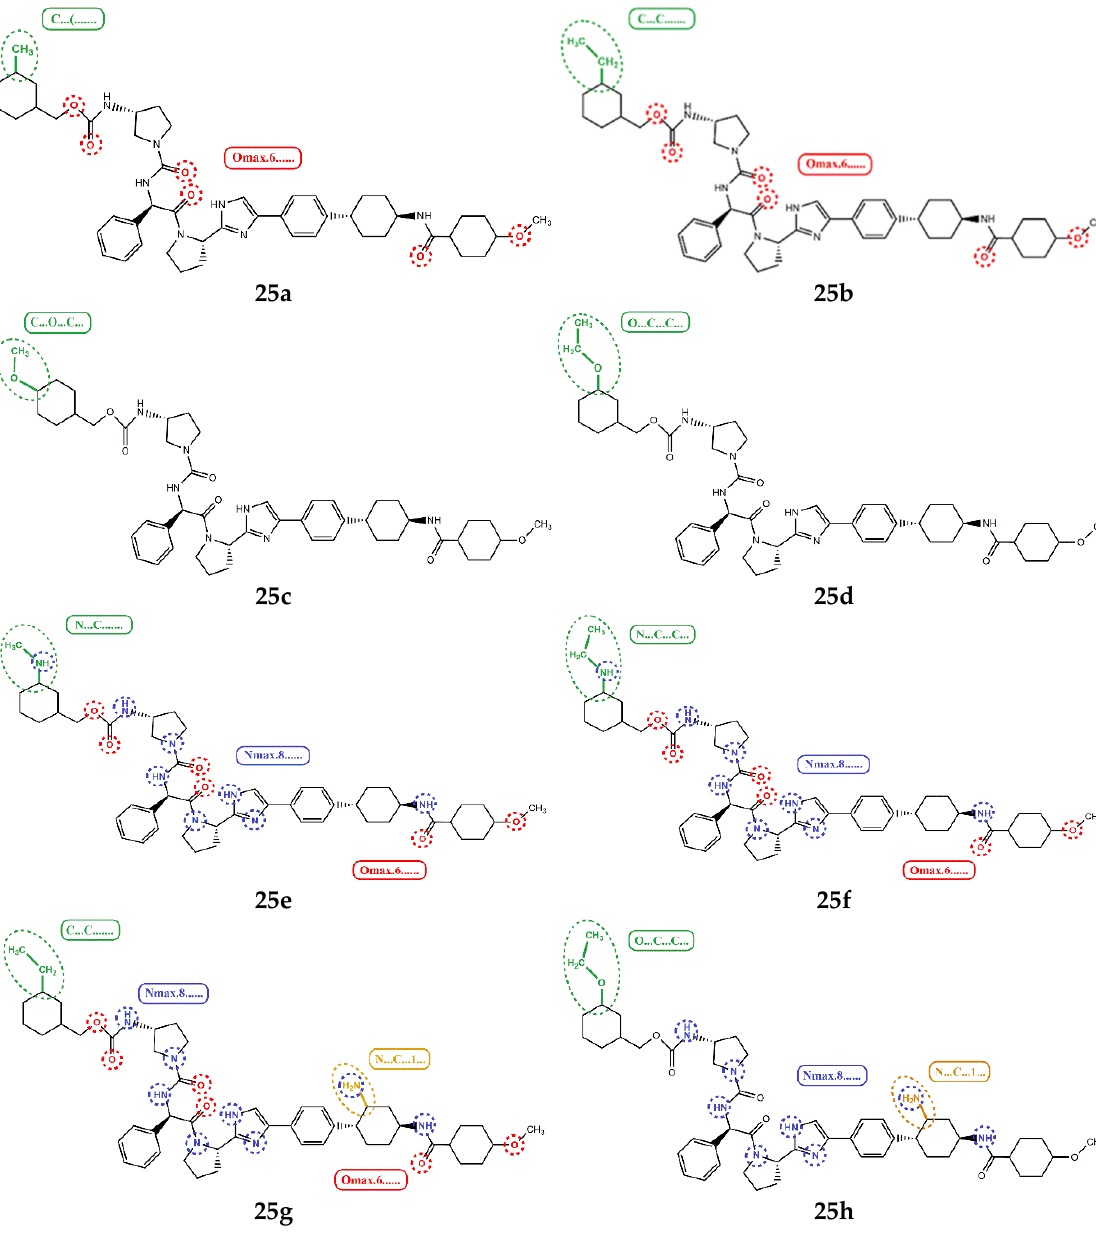
Figure 3. Chemical structures ( 25a – 25h ) of the newly designed compounds with favorable structural